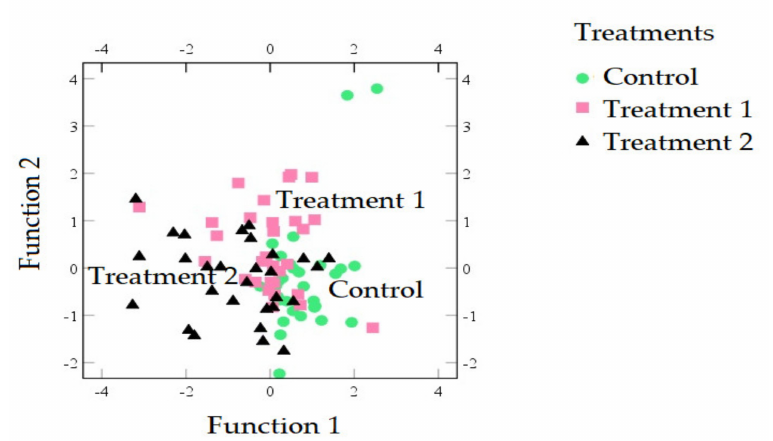
Figure 2. Distribution of the sausages in the coordinate system defined by the two discriminant functions used to di ff erentiate among sausages stu ff ed in control (green circles), treatment 1 (pink squares), and treatment 2 (black triangles)